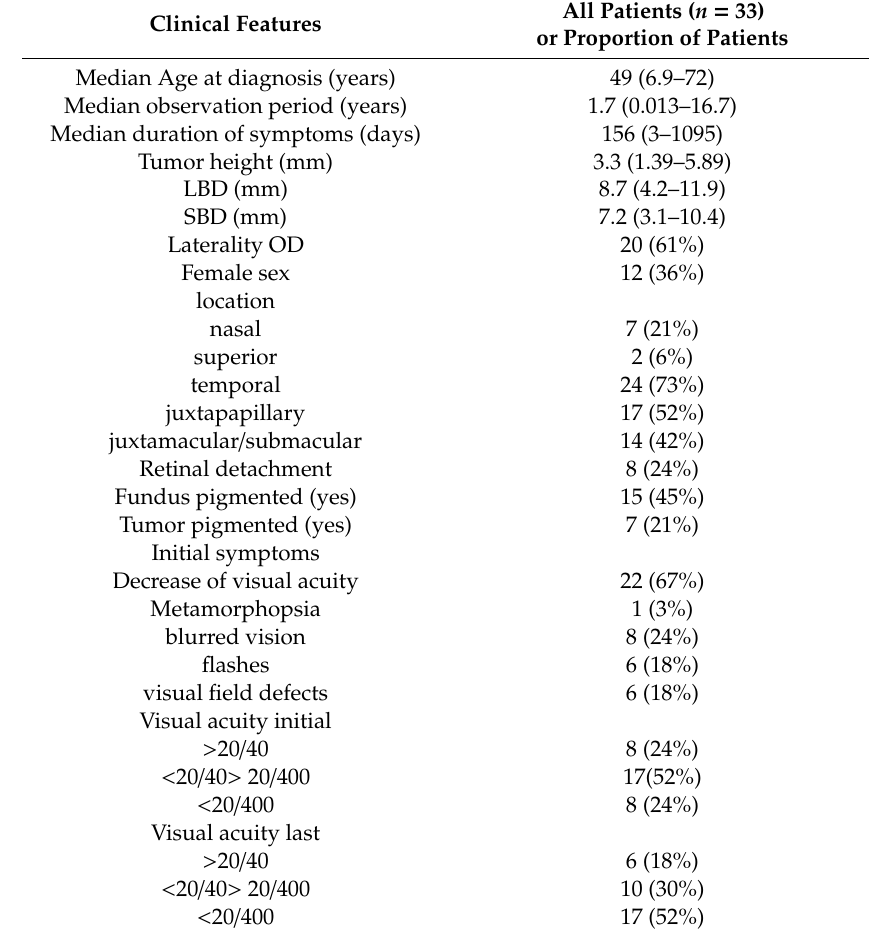
Table 1. Clinical characteristics of 33 CCH